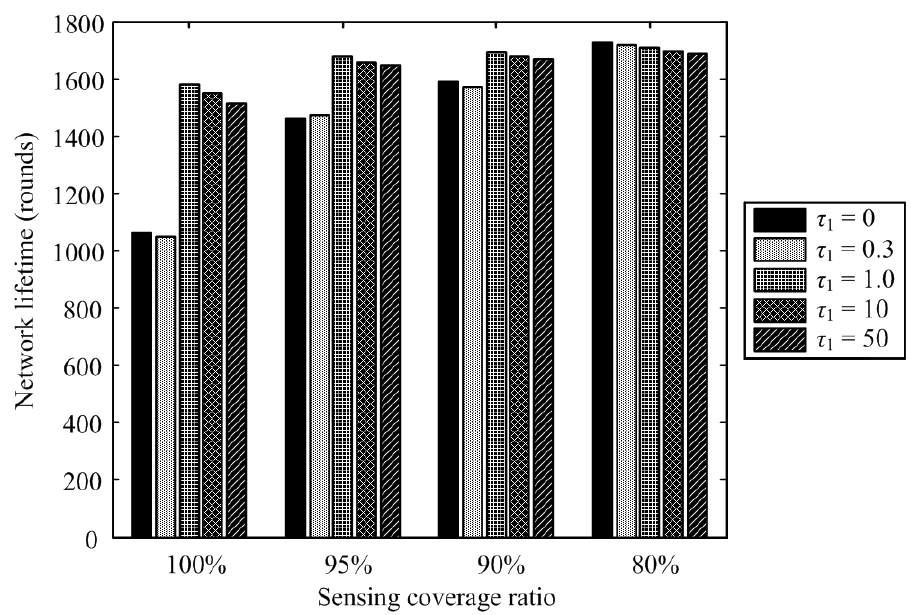
Figure 5. Comparison of network lifetimes under different sensing coverage ratios with varying τ when set τ = 1 2